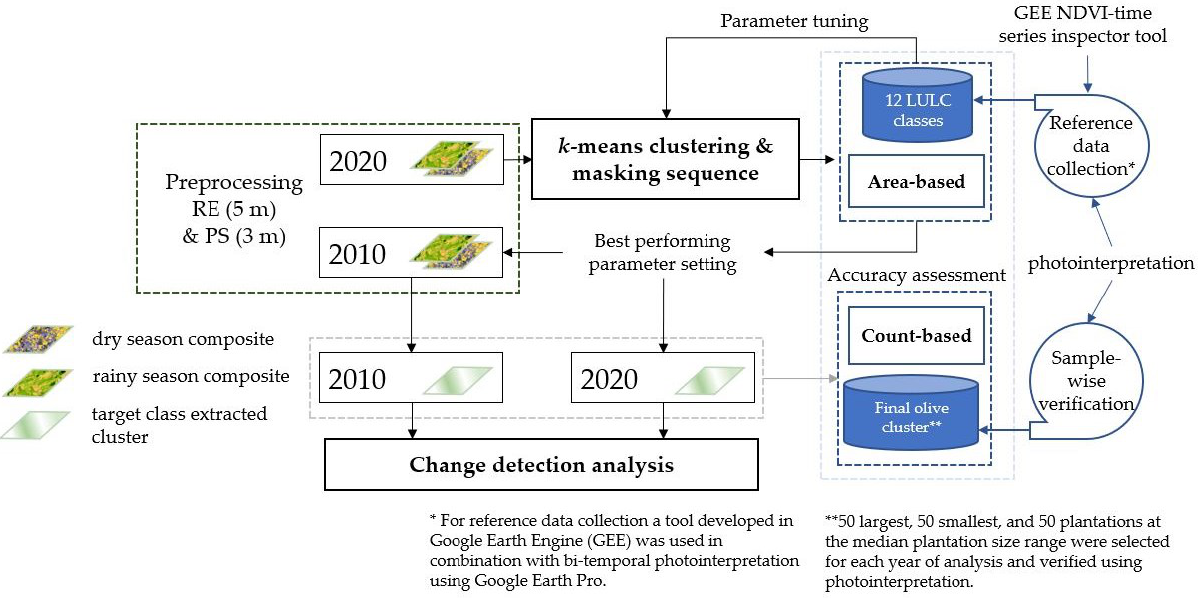
Figure 2. Workflow overview.